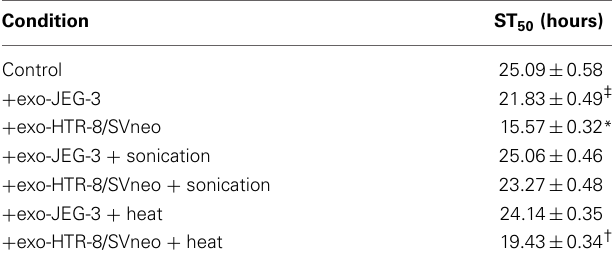
Table 1 | Kinetic characteristic of exosome effects on